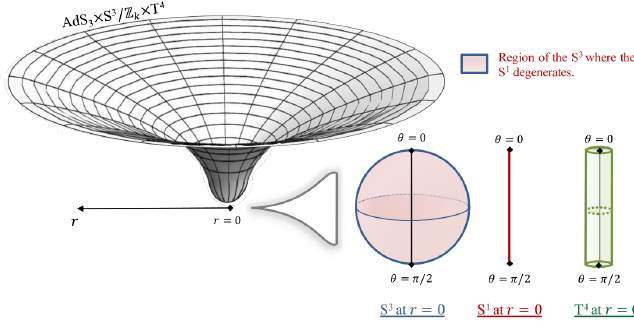
Figure 3 . Schematic description of the spacetime built from a single rod inducing the degeneracy of the S 1 . On the left-hand side, we depict the overall geometry in terms of the radius r . On the right-hand side, we describe the behavior of the S 3 , S 1 , and T 4 at r = 0 and as a function of θ , the S 3 coordinate. Global AdS S 3 × T 4 ends smoothly as a coordinate degeneracy of the S 1 at r = 0 3 × and the T 4 is